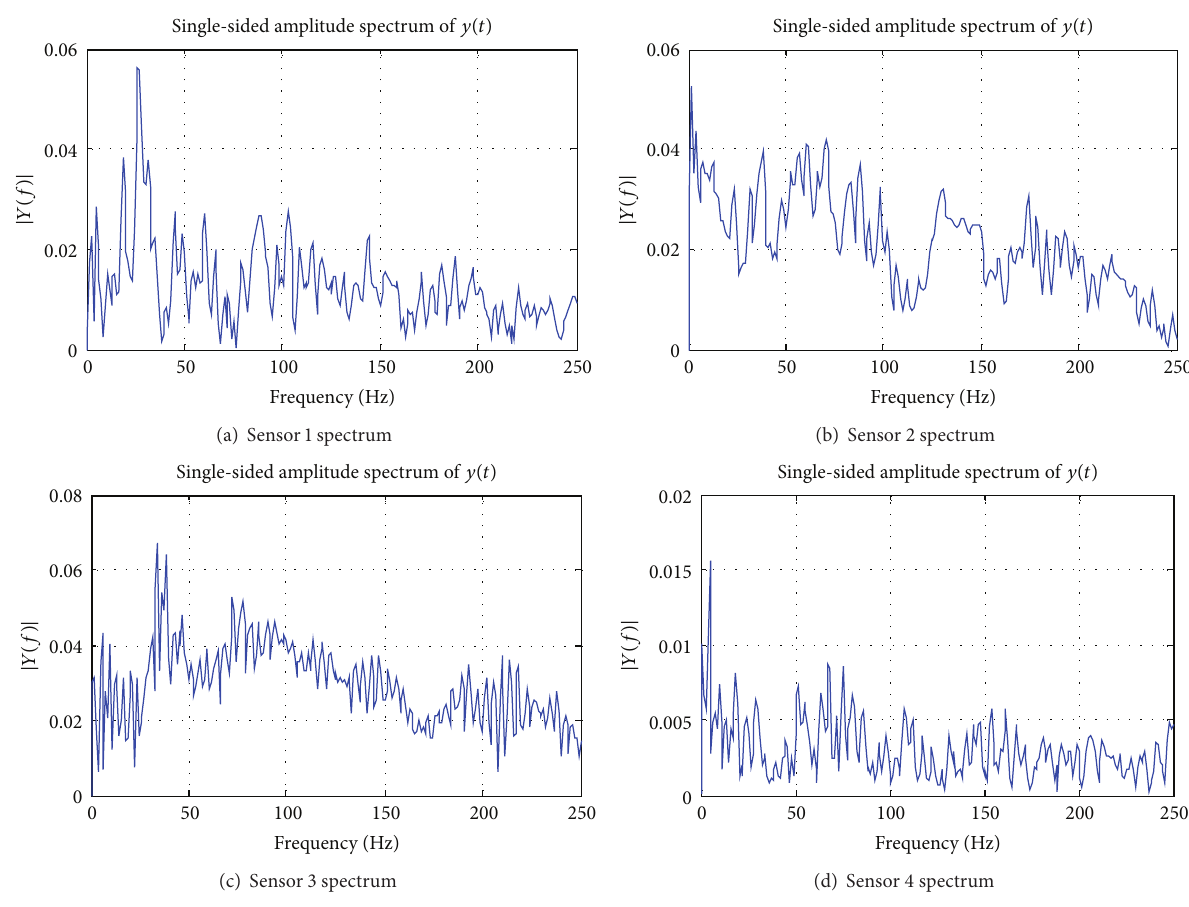
Figure 11: Sensors spectrum of the landing mechanism with 𝑉 𝑦 = 1.17 m/s, 𝑉 𝑥 = 0 m/s, and 𝜃 = 10 ∘ .